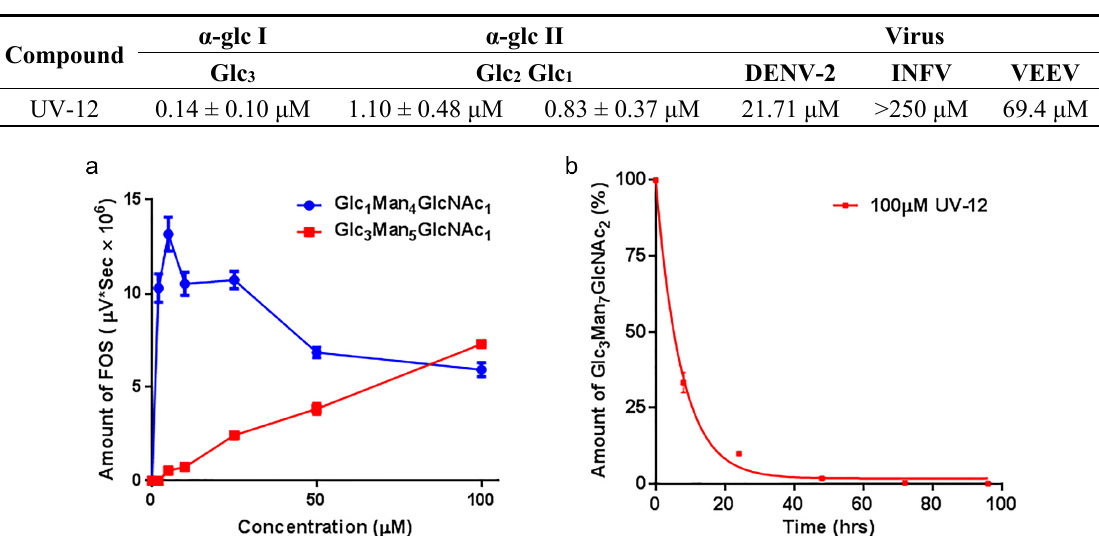
Table 1. Iminosugars are potent ER α -glucosidase inhibitors and can inhibit viral replication in vitro . UV-12 was tested for the ability to inhibit rat liver ER α -glucosidases I and II on oligosaccharide substrates, Glc (1-3) Man (4-7) GlcNAc (1-2) isolated from cultured cells. The mean and SD of the IC 50 from triplicate assays is shown. Viral inhibition was tested using a yield/plaque assay with multiple concentrations of UV-12. The mean from duplicate assays is shown.